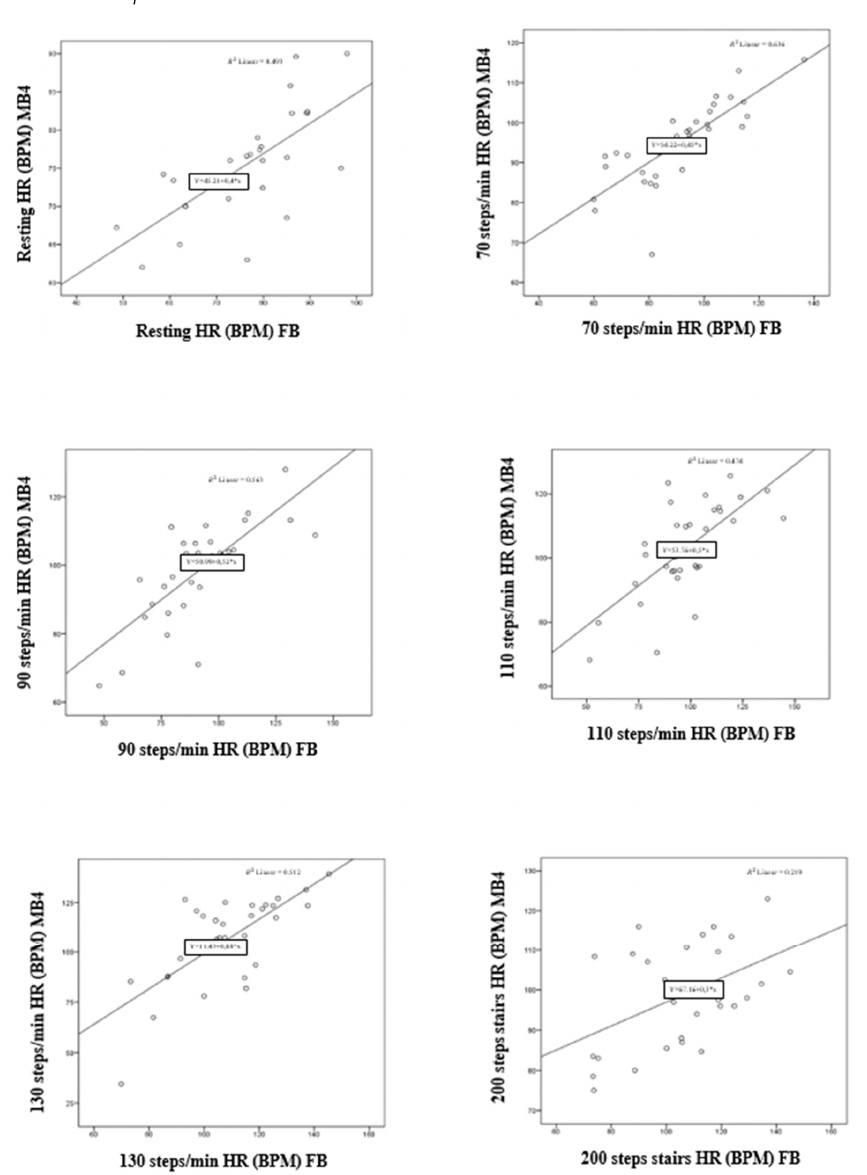
Figure 6. Scatter plots of HR recorded by the MB4 wristband and FB heart sensor during (from top to bottom and from left to right): resting, walking at 70–90–110–130 steps per minute and walking up and down 200 stairs.